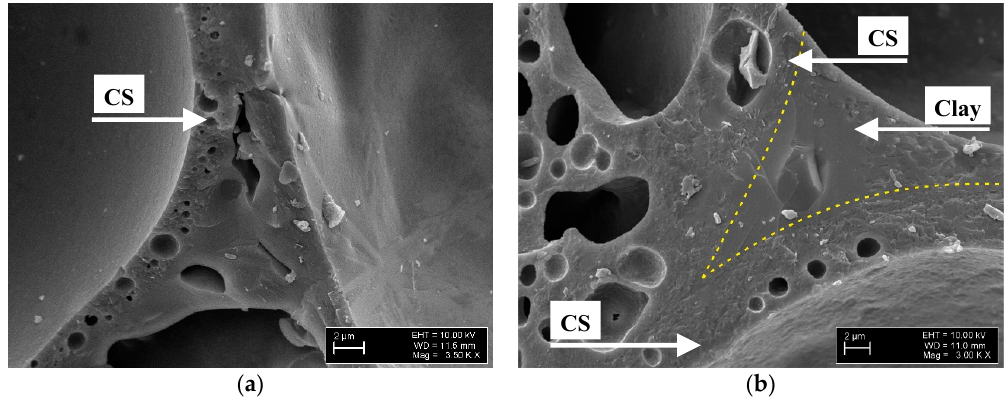
Figure 5. SEM images of CE-5 samples fracture fired at 1000 °C with 50 vol % of CS addition, ( a ) at a magnification of ×3500; ( b ) at a magnification of ×3000. Materials 2017 , 10 , 828